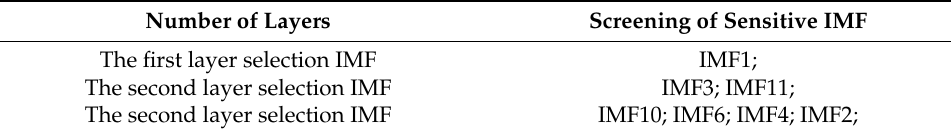
Table 2. Sensitive IMF selection based on information